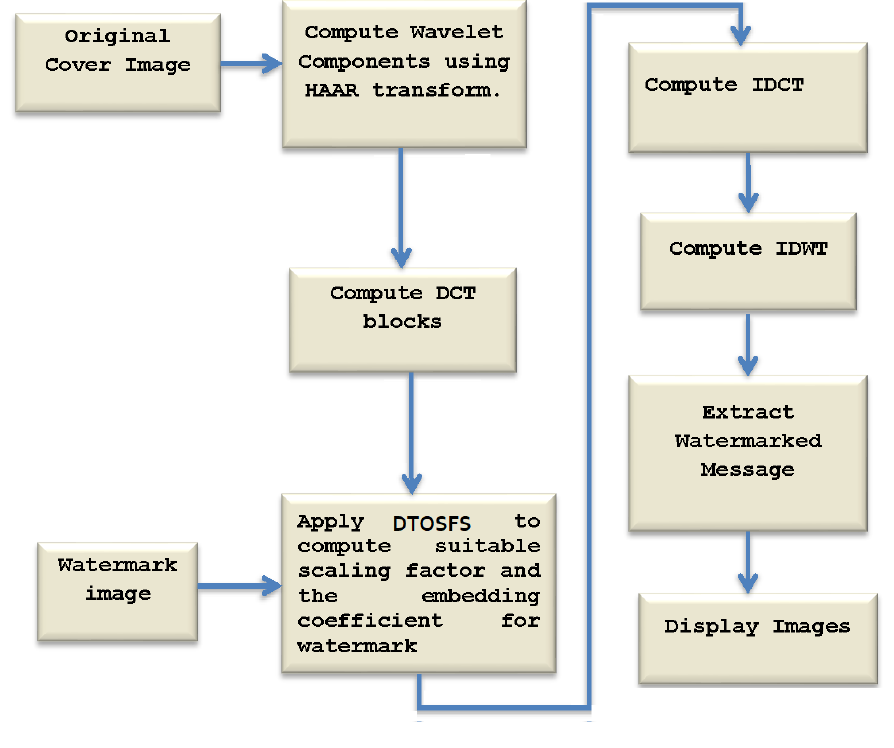
Figure 4. The detailed steps of the proposed